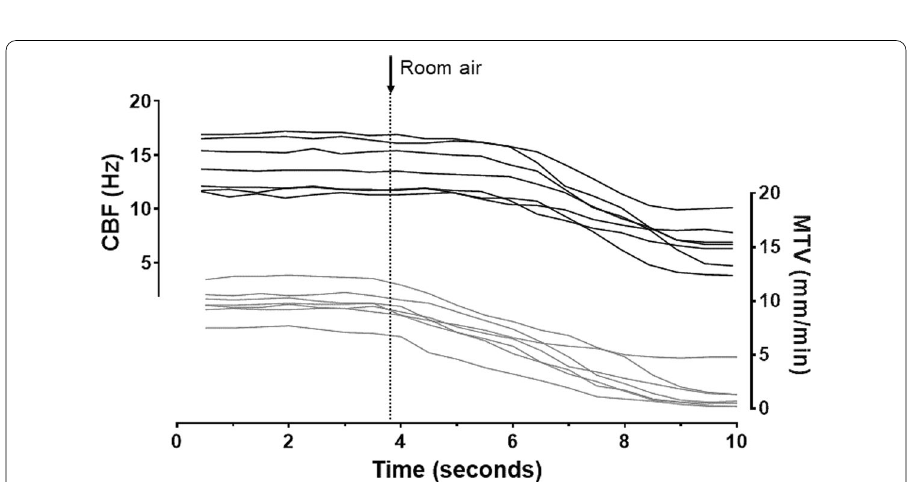
Fig. 4 Cilia beat frequency (CBF) (black) and mucus transport velocity (MTV) (gray) measured over time. The dotted vertical line marks the change in air passing above the surface from body temperature and fully saturated with water vapor (38 °C and 100% relative humidity) to room air (22 °C and 50% relative